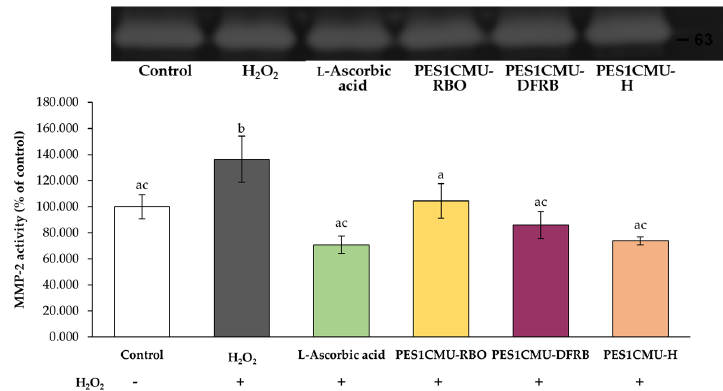
Figure 5. Effects of rice bran oil (PES1CMU − RBO), defatted rice bran extract (PES1CMU − DFRB), and husk extract (PES1CMU − H) of Oryza sativa L. cv. PES1CMU extracts on MMP − 2 expression in